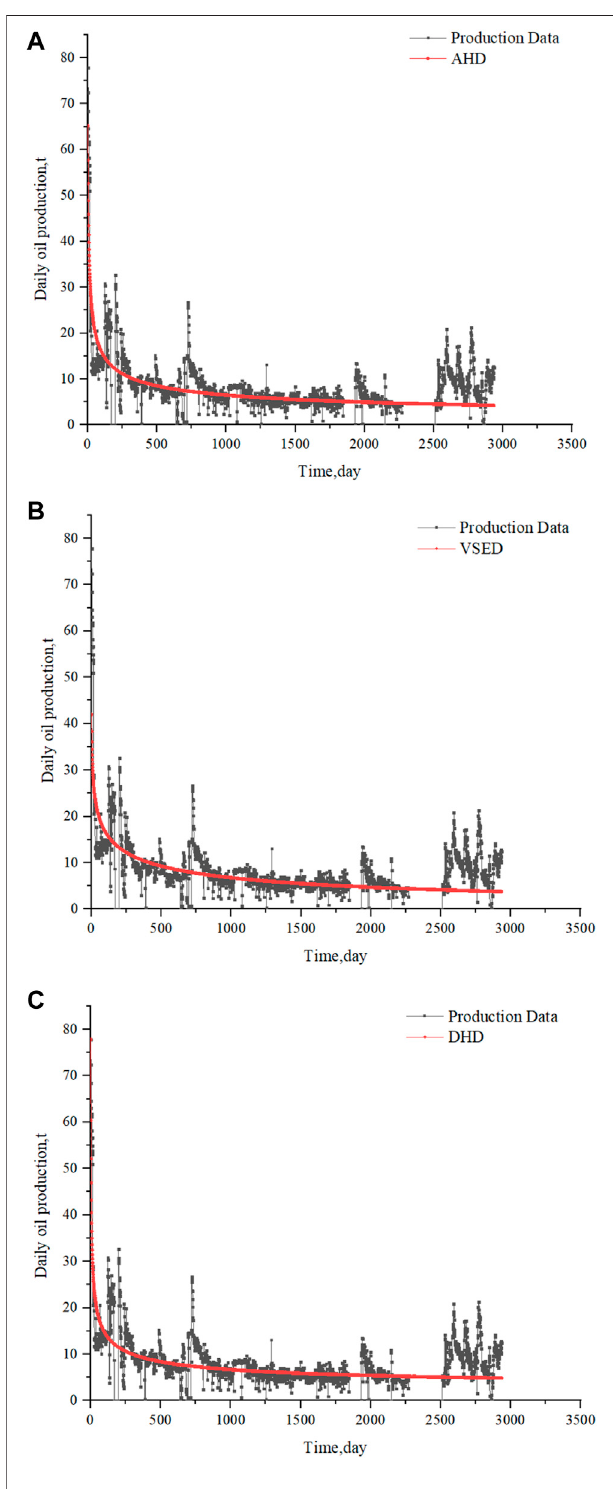
FIGURE 11 | Three decreasing fi tting curves of Well JI172_H: (A) AHD fi tting curve of Well JI172_H, (B) VSED fi tting curve of Well JI172_H, and (C) DHD fi tting curve of Well